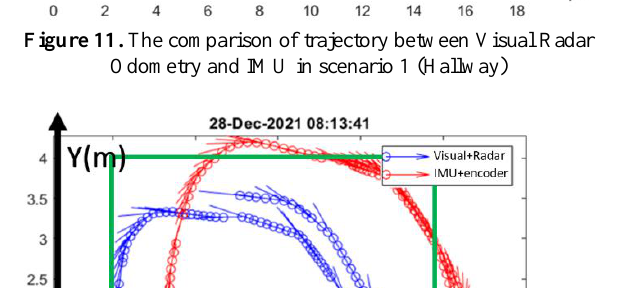
Figure 9. The comparison of trajectory between Radar Aided VO and pure VO in scenario 1 (Hallway)